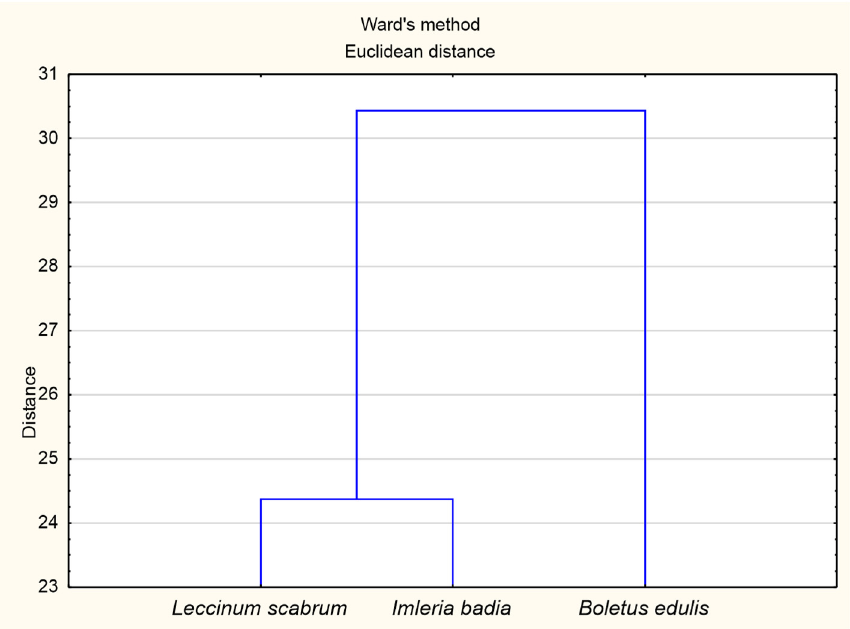
Figure 3. Ward’s cluster analysis for macronutrients content in the mushrooms ( L. scabrum , I. badia , B. edulis ).